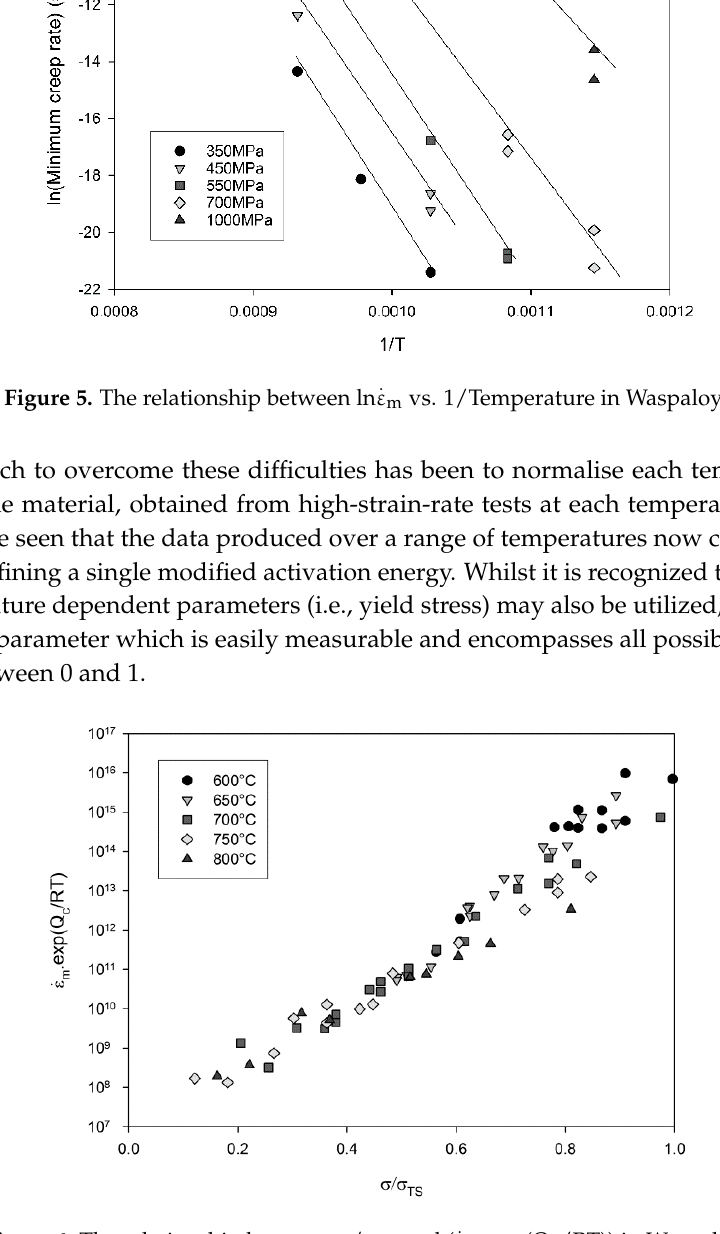
. ε m · exp(Q c /RT)) in TS and (